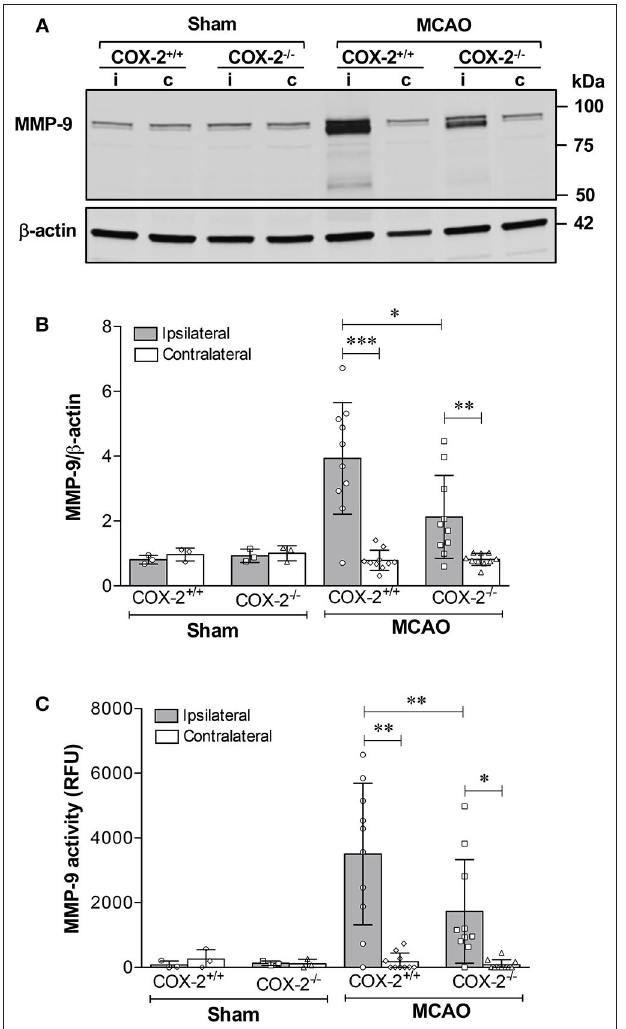
FIGURE 3 | Genetic deletion of COX-2 significantly reduces MMP-9 activity and protein content in the ischemic brain. Transient focal cerebral ischemia followed by 24h of reperfusion produced a dramatic increase in MMP-9 protein levels in the ipsilateral cerebral cortex as shown by immunoblotting. COX-2 − / − mice had a significant reduction in MMP-9 levels after ischemia compared with COX-2 + / + . (A) Representative western blot for MMP-9 in cortical homogenates from ipsilateral (i) and contralateral (c) cortex. (B) Densitometric analysis of MMP-9 relative to β -actin. Reduced MMP-9 protein content was seen in COX-2 − / − compared with COX-2 + / + at 24h following MCAO. (C) Fluorometric immunocapture assay of MMP-9 activity measured at 24h in the cerebral cortex following transient ischemia showed a significant increase in COX-2 + / + mice ( ∼ 8-fold increase with respect to contralateral). Compared with the wild-type, COX-2 − / − mice had a significant reduction in MMP-9 activity. For (B,C) , statistical analyses were performed using two-way ANOVA with Bonferroni post-tests. Significance was defined as * P < 0.05, ** P < 0.01, and *** P < 0.001. Data are presented as mean ± SD. n = 10 in ischemic groups of each genotype. Sham-operated groups ( n = 3).